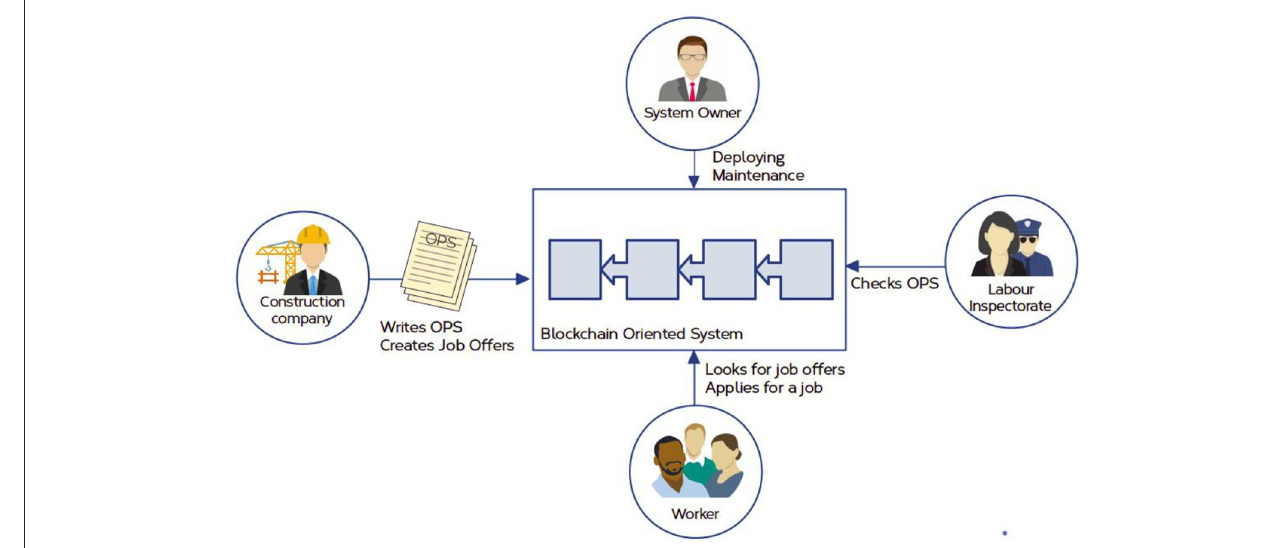
FIGURE 1 | A high level representation of the BOS system and its